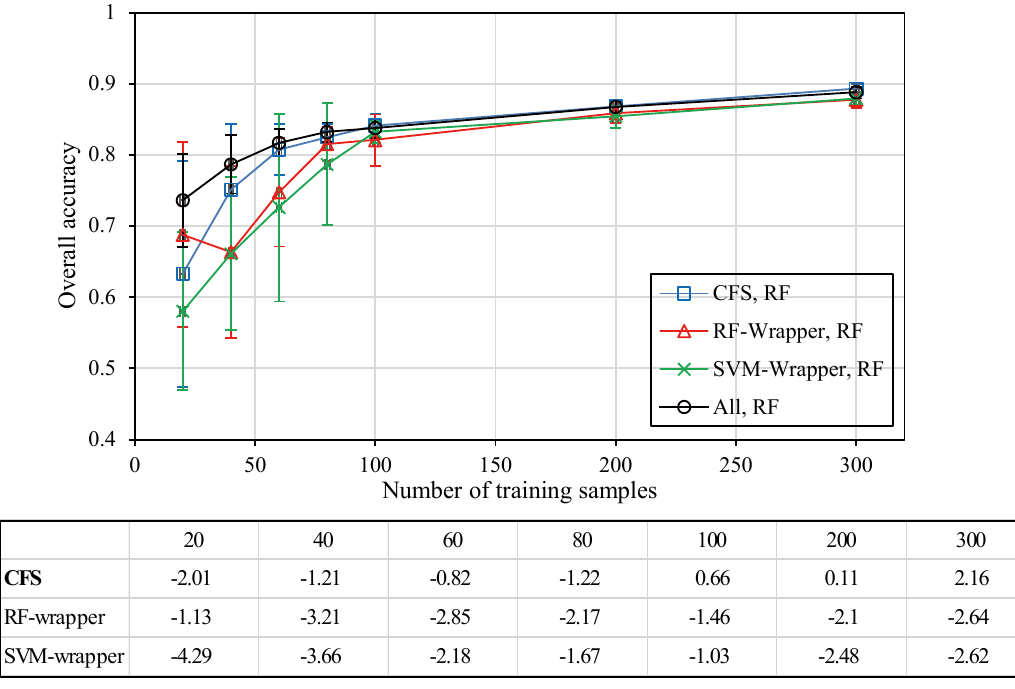
Figure 4. The overall accuracy versus the training set size obtained by the different feature subset using the RF classifier. The statistical value derived from a two-tailed t -test reveals whether there is a significant difference in the classification accuracy between the selected feature subset and the full set of features.